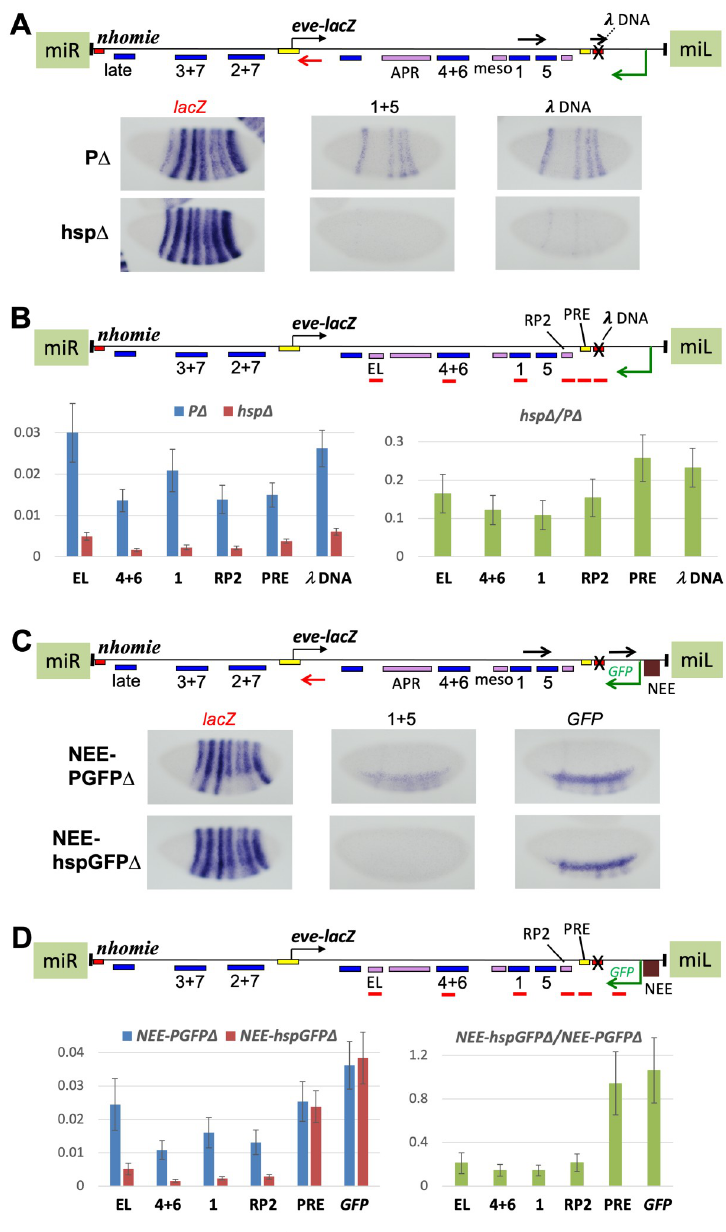
Fig 7. Processivity of read-through transcription from flanking promoters correlates with degree of repression of the eve promoter. Transgenes are at the same MiMIC site, and in the same orientation, as in Fig 4. All loci have homie replaced with phage λ DNA (refer to map above each one). (A) eve-lacZ and flanking promoter-driven RNA expression in stage 5 embryos. Positions and orientations of the RNA probes used are shown as black and red arrows in the map. Images are labeled (above) with black lettering corresponding to black arrows, or red lettering corresponding to red arrows. Top row : transgene with P-element promoter (P Δ , also used in Fig 4B). Bottom row : transgene with hsp70 core promoter (hsp Δ ). Note that neither promoter has either the NEE or a GFP coding region. (B ) Quantification of total RNA (normalized to RP49 RNA) from the indicated enhancer regions (probed regions are shown as red bars in the map) in the P Δ and hsp Δ lines. Averages with standard deviations of 4 biological samples each from hsp Δ and P Δ are graphed on the left, and the ratios of average signals (with standard deviations) are graphed on the right. (C ) Same as in A, except that the both promoters have the NEE and a GFP coding region (but no polyA signal). (D ) Same as in B, except that the promoters are as described in C.